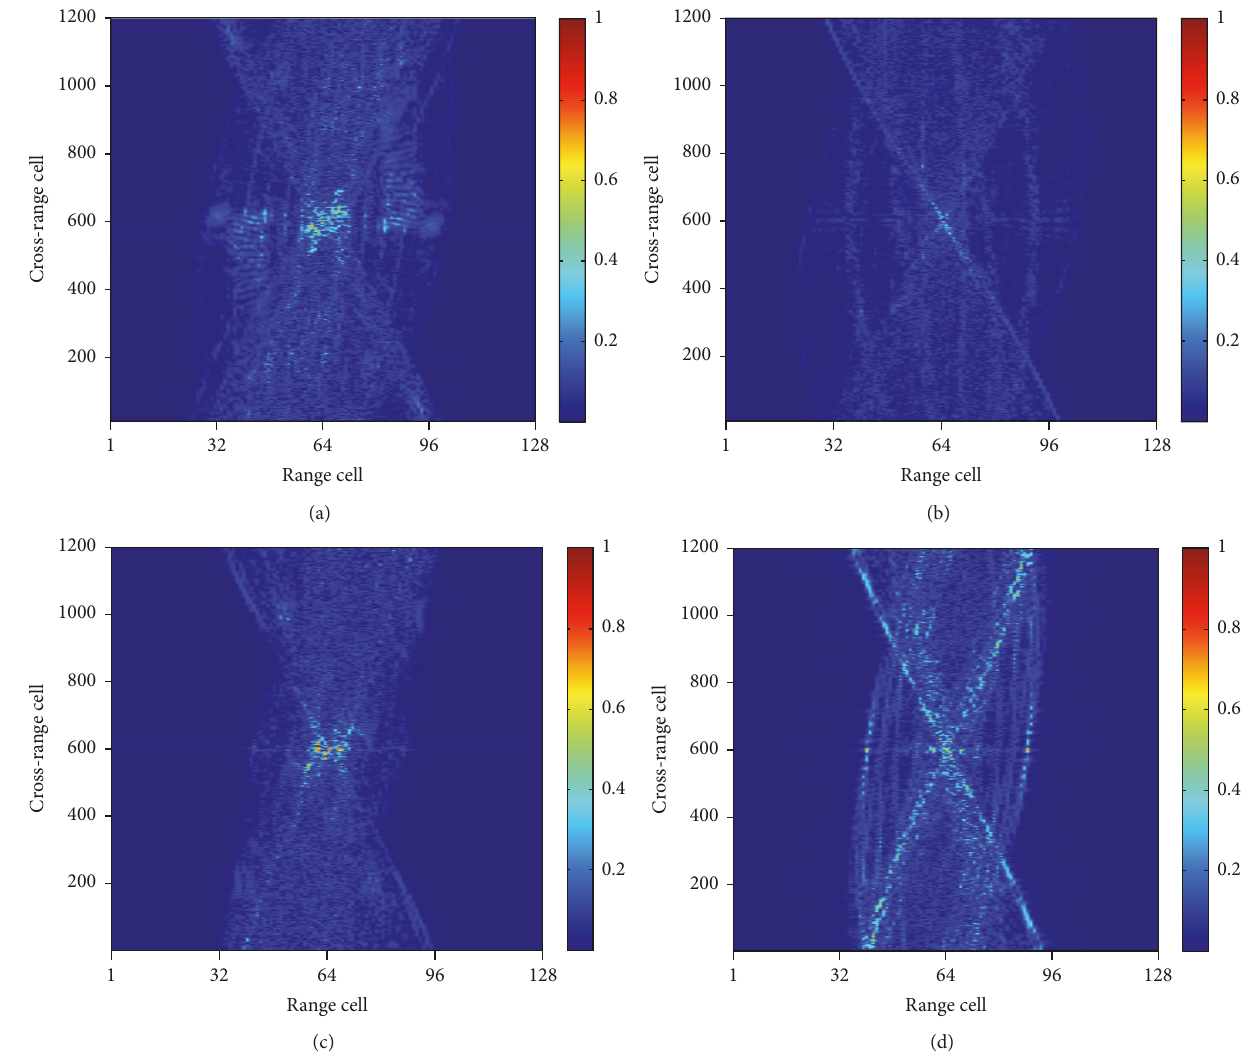
Figure 2: Normalized range profiles obtained by FFT with no noise: (a) Target 1, (b) Target 2, (c) Target 3, and (d) Target